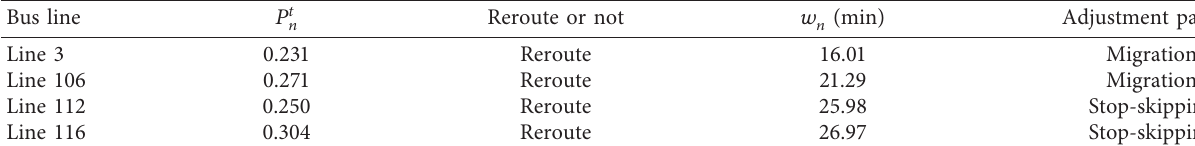
Table 3: Determine the adjustment patterns for the bus lines.